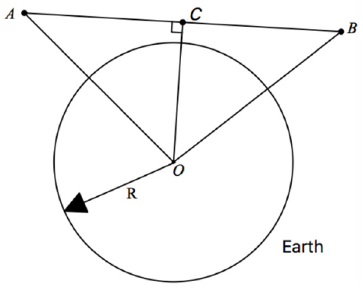
Figure 1. A pair of visible satellites.